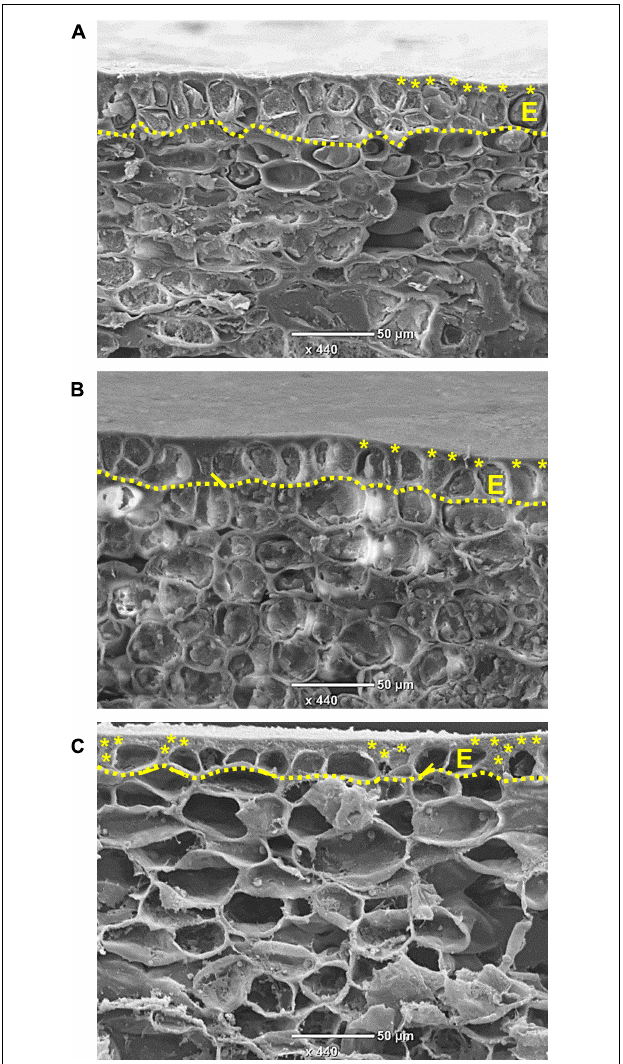
FIGURE 3 | Pomegranate skin observed by scanning electron microscope. Micrographs were taken at 8 (A) , 11 (B) , and 24 (C) weeks after full bloom during the year 2014. Dotted line outlines the epidermal layer (E), and asterisks mark the cuticular layer and cuticular pegs between the cells. Bar = 50 µ m.